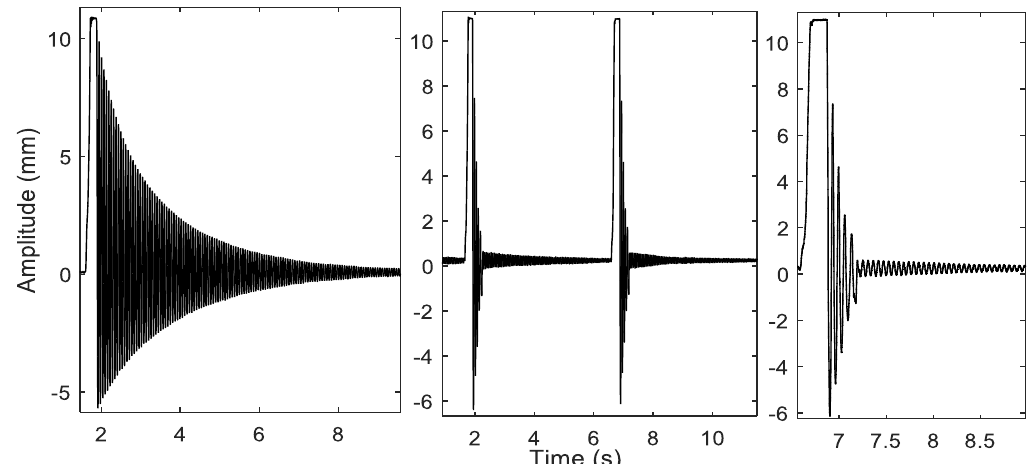
Fig. 7 Closed loop impulse response with the integer order controller: free impulse response (left), active suppression (center), and zoomed active suppression